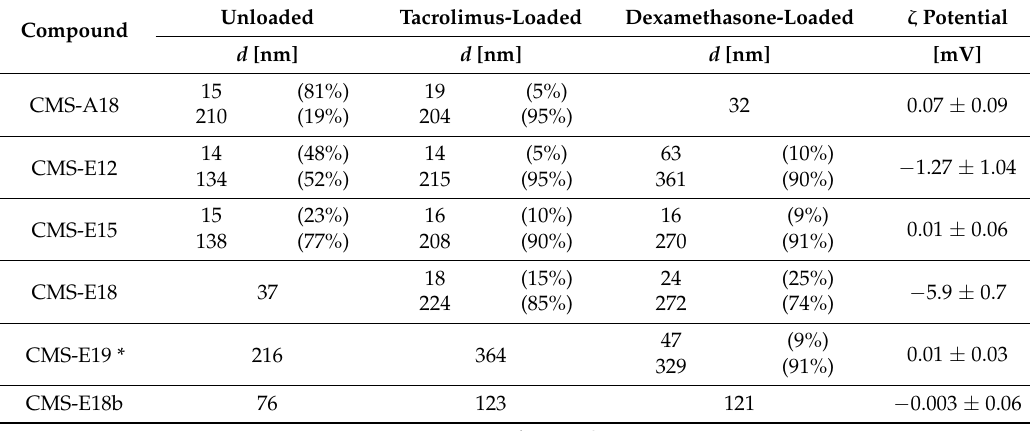
Table 2. Intensity-based hydrodynamic diameters of unloaded and loaded CMS nanocarriers and the